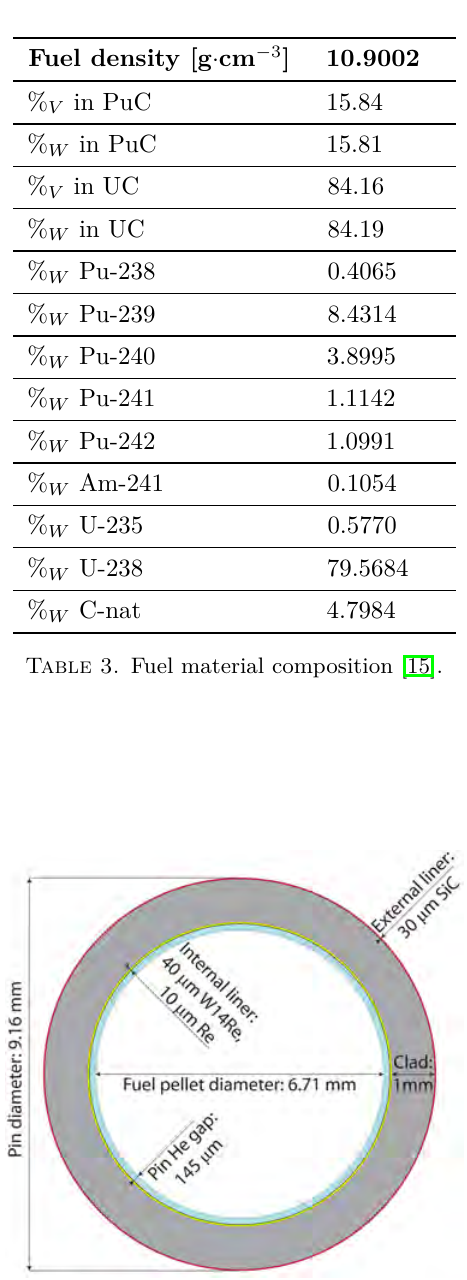
Figure 3. Cross sectional view of the GFR 2400 fuel pin